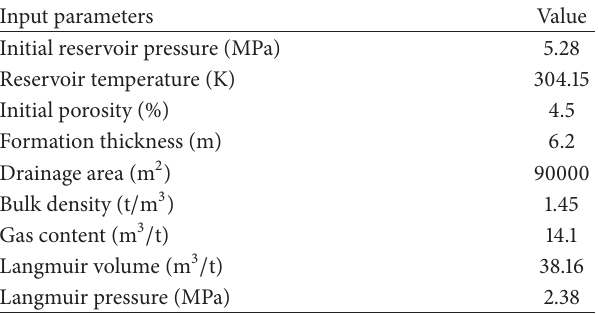
Table 2: Parameters of coal reservoir.